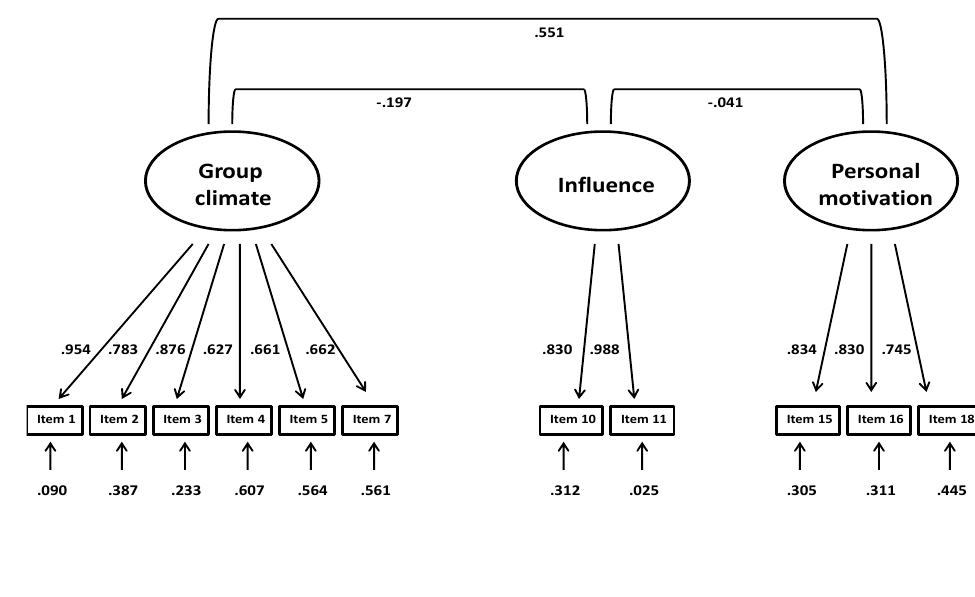
Figure 1 Three-Dimensional Model of Perceptions of Collaboration